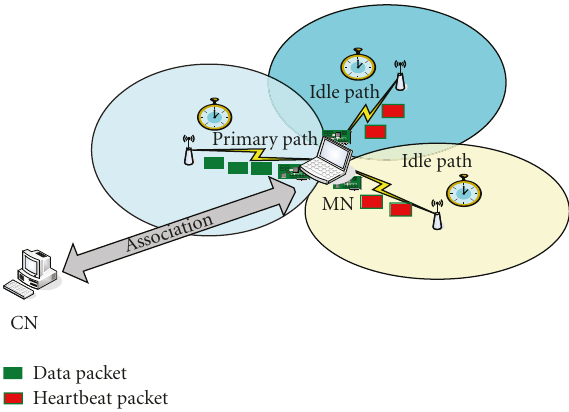
Figure 1: SCTP path failure detection